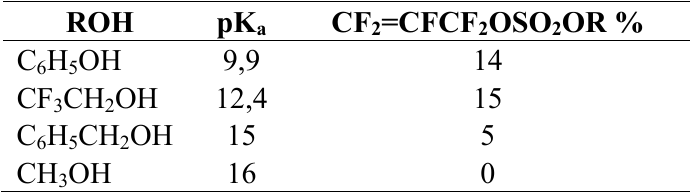
and substitution selectivity on FAFS. a